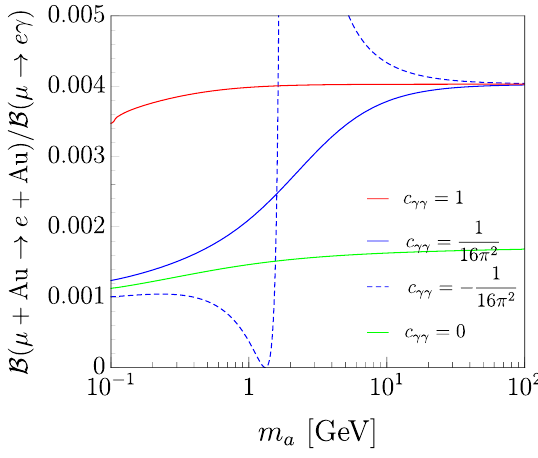
a ‘ universal and ii (cid:17)